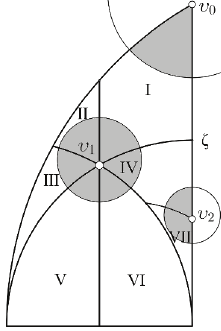
Figure 10. Number ε 0 > 0 is chosen in such a way that each circle with center at v 0 , v 1 , or v 2 , and radious ε 0 only overlaps the regions with boundary containing its